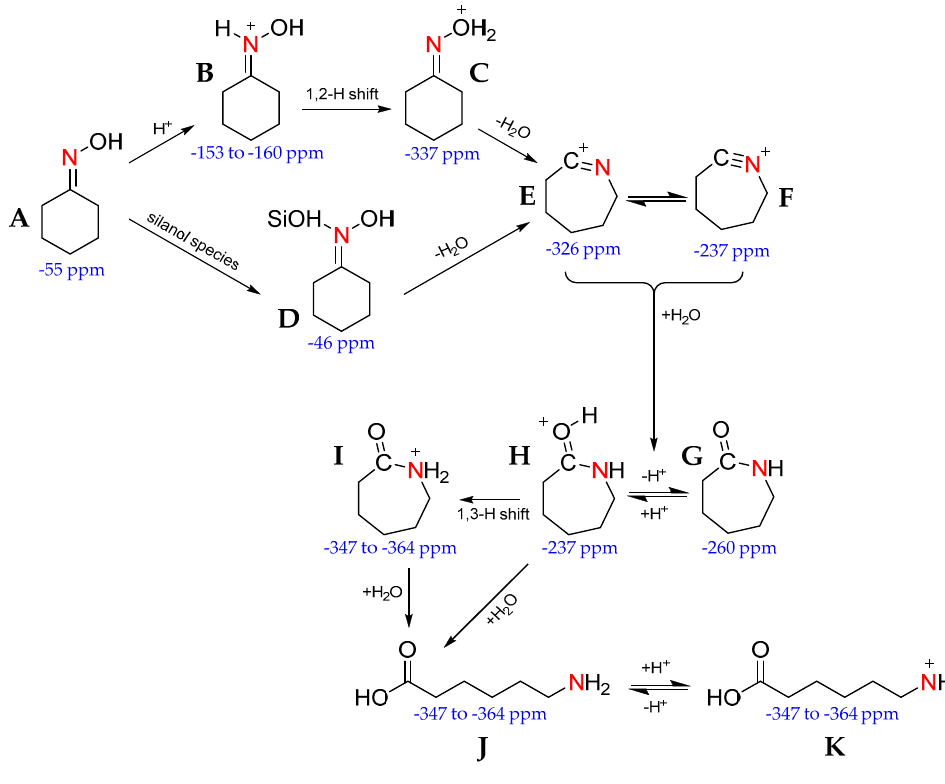
Scheme 4. The mechanism of the Beckmann rearrangement, determined experimentally using 15 N- MAS-NMR on Silicalite-1 and H-ZSM-5 and 15 N-labelled cyclohexanone oxime. The numbers in blue indicate the 15 N chemical shifts assigned using DFT modelling (modified from references 98,